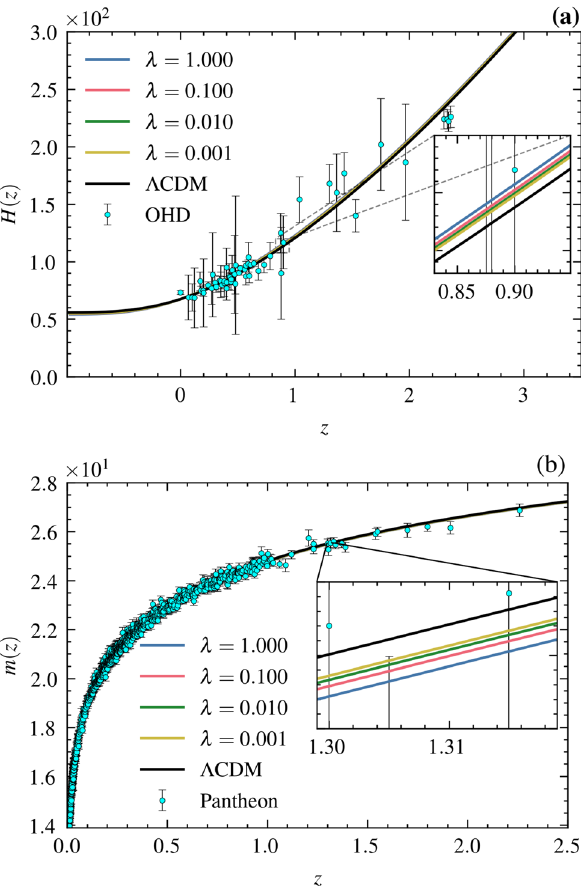
Fig. 7 a Hubbleparameter( H ( z ) )and b apparentmagnitude( m ( z ) )of Type-1asupernovaeasafunctionofredshift( z )fordifferentvaluesof λ . Here we took M = − 19 . 366 as the nuisance parameter [93] to estimate the apparent magnitude (with (cid:12) m 0 = 0 . 315 and H 0 = 67 . 4 km/s/Mpc [78]). Observational Hubble Data from [79] and Pantheon data from